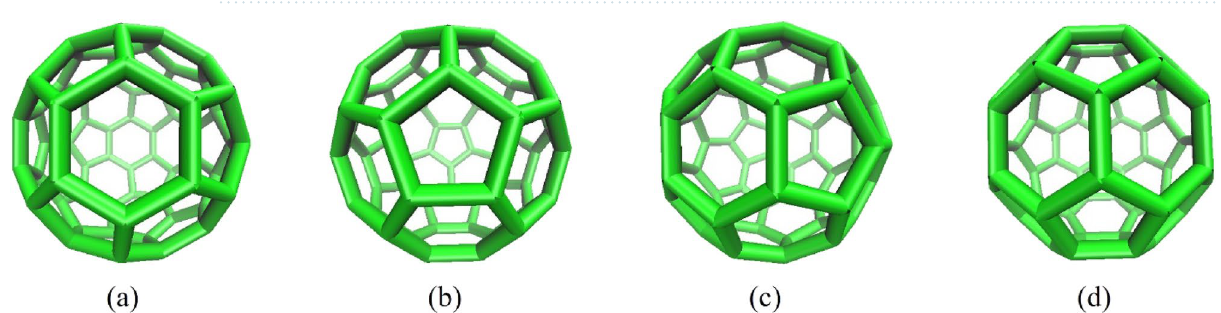
Figure 3. Orientations of C 60 on gold surface (bottom view). ( a ) C 60 on a hexagonal face ( b ) C 60 on a pentagonal face ( c ) C 60 on a bond between a pentagonal and a hexagonal faces ( d ) C 60 on a bond between two adjacent hexagonal